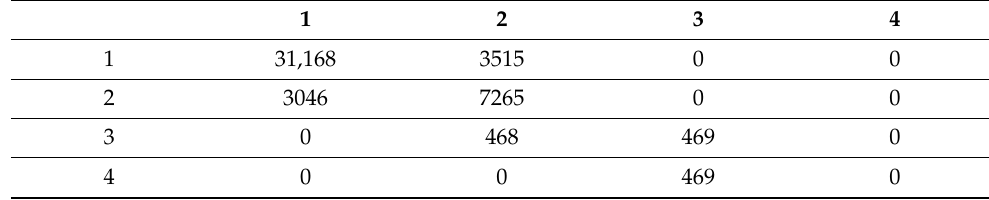
Table 6. The confusion matrix for bagging.